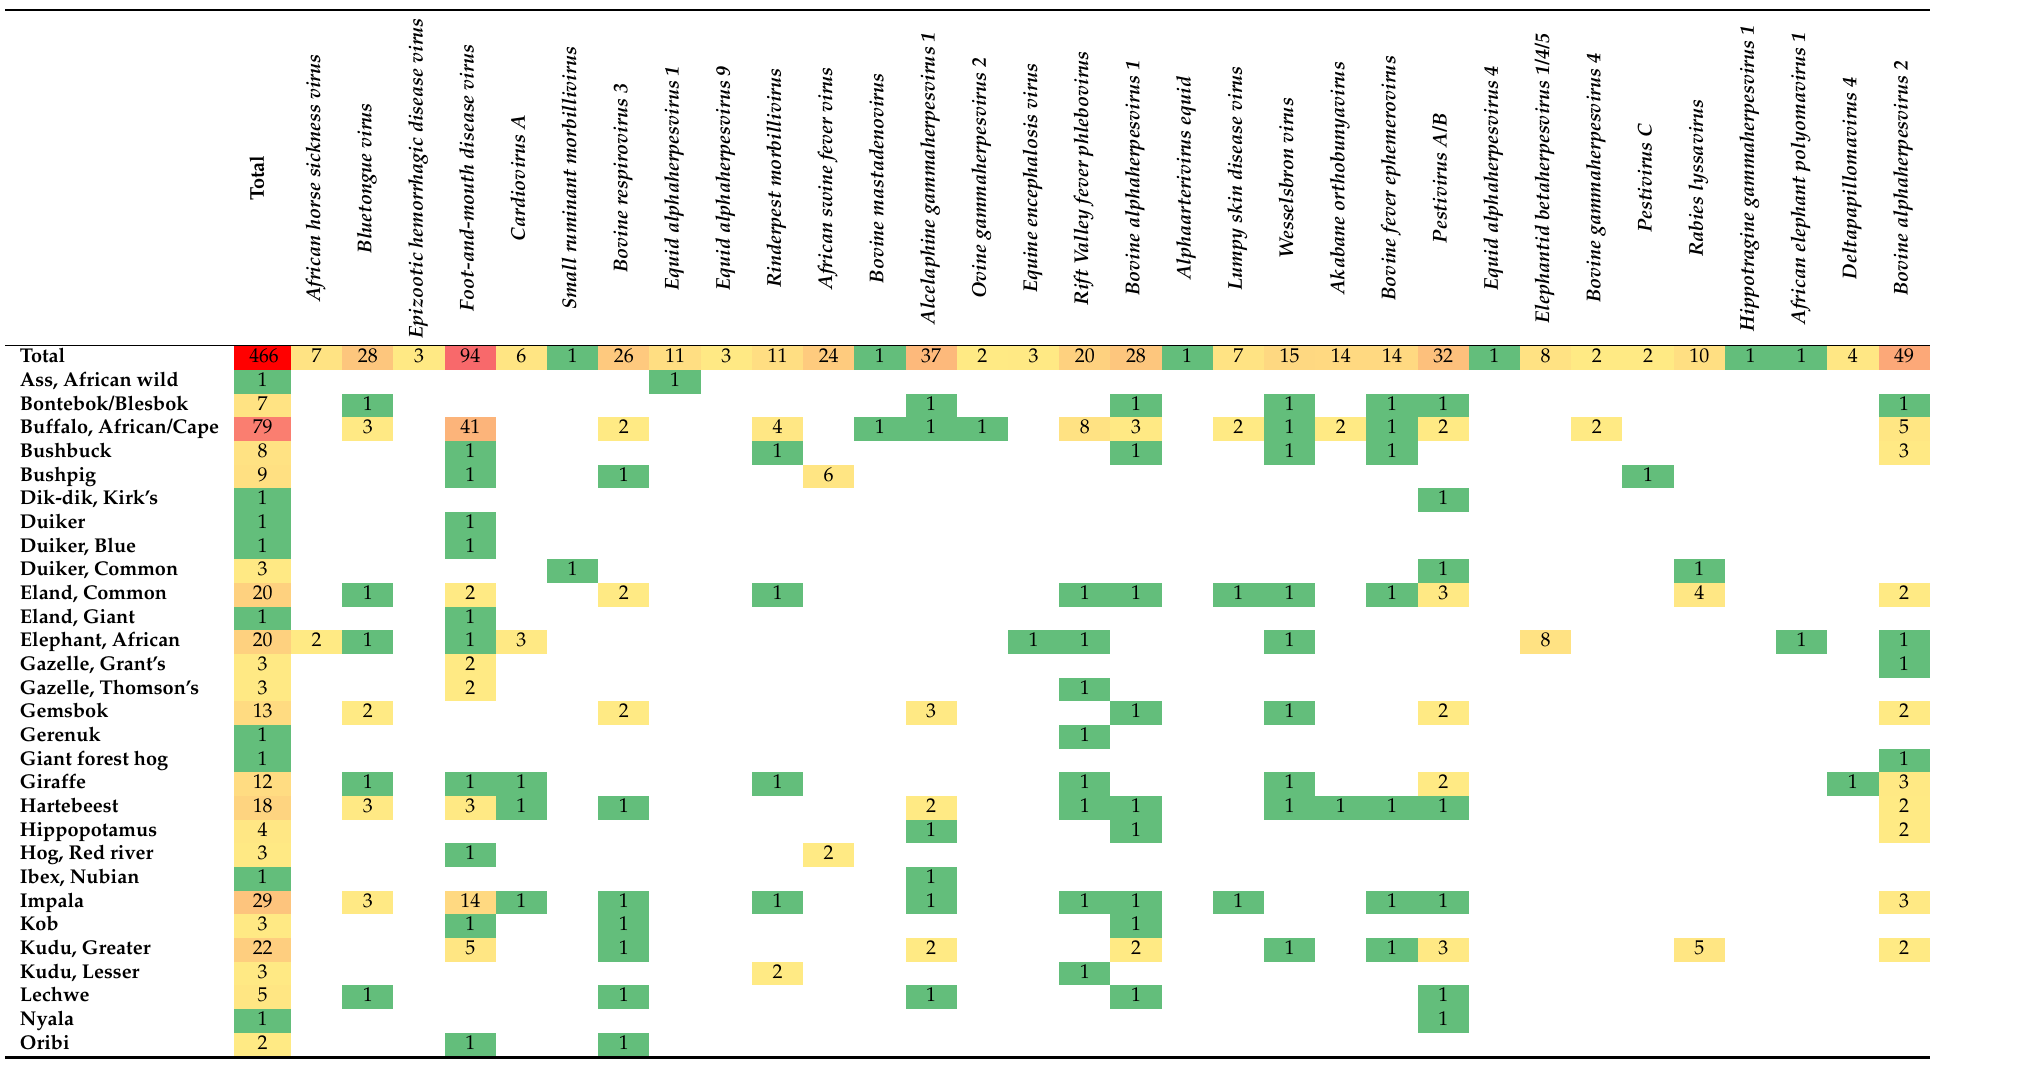
Table 3. Number of publications indicating detection of viral antigen/antibody in each species of African